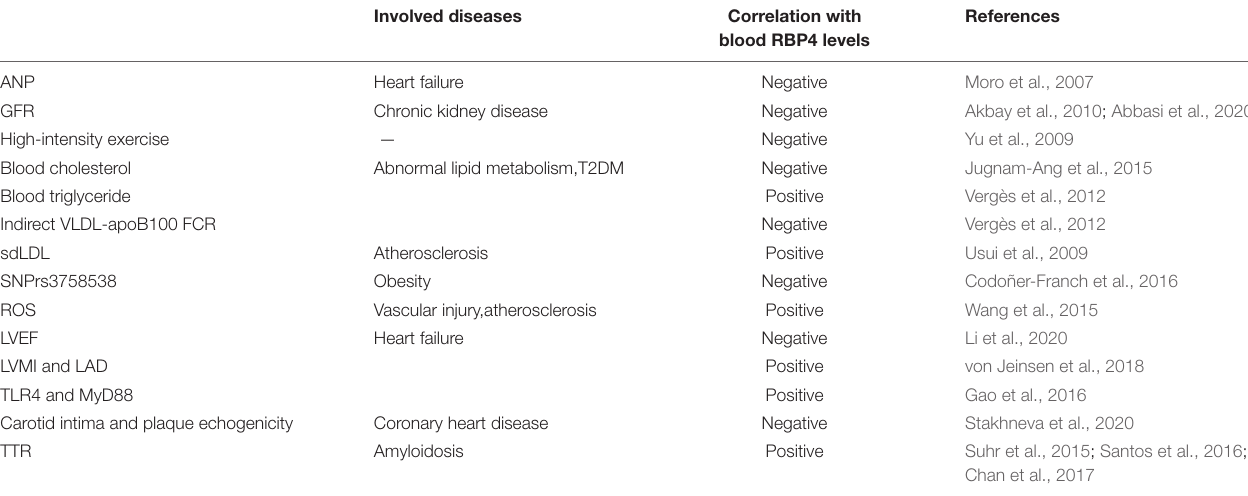
TABLE 1 | Associated factors and diseases correlated with RBP4